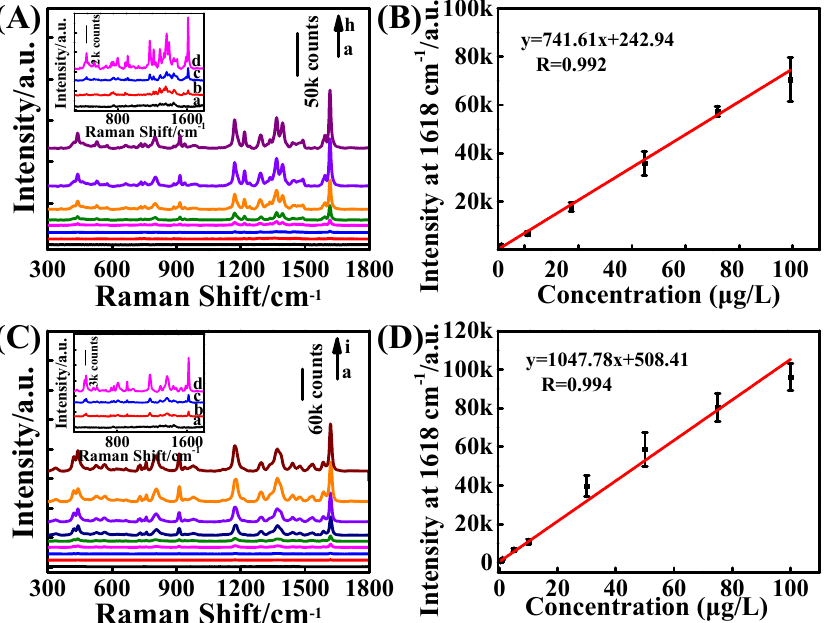
Figure 4. SERS detections of MG and CV on Au NRs@TiO 2 substrates, respectively. ( A ) The Raman spectrum of MG at different concentrations, from 0 to 100.0 μ g/L (a-h), and the insert was from 0 to 10.0 μ g/L (a-d). ( B ) Calibration plots for quantitative detection of MG were from 0.75 to 100.0 μ g/L. ( C ) The Raman spectrum of CV at different concentrations, from 0 to 100.0 μ g/L (a-i), and the insert was from 0 to 5.0 μ g/L (a-d). ( D ) Calibrations plot for quantitative detection of CV were from 0.50 to 100.0 μ g/L .